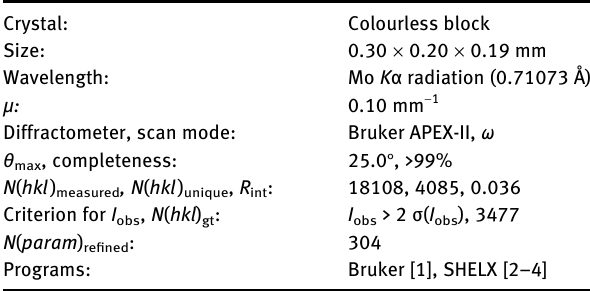
Table  : Data collection and